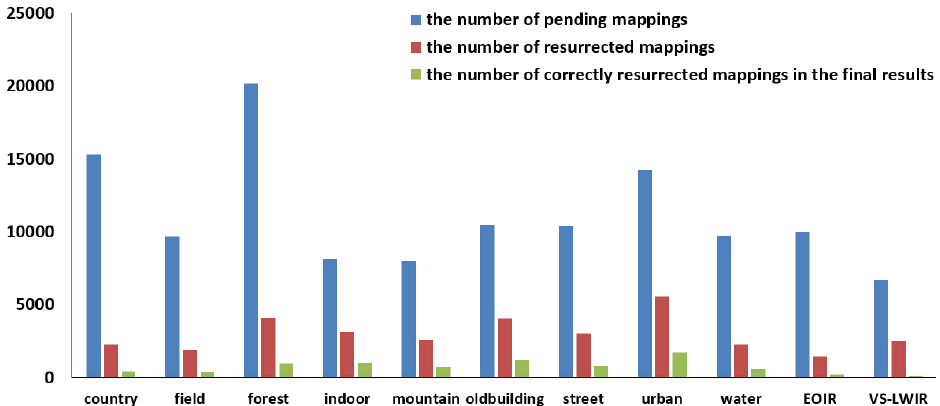
Figure 5. On each dataset, from left to right: the number of pending mappings, the number of resurrected mappings and the number of resurrected correct